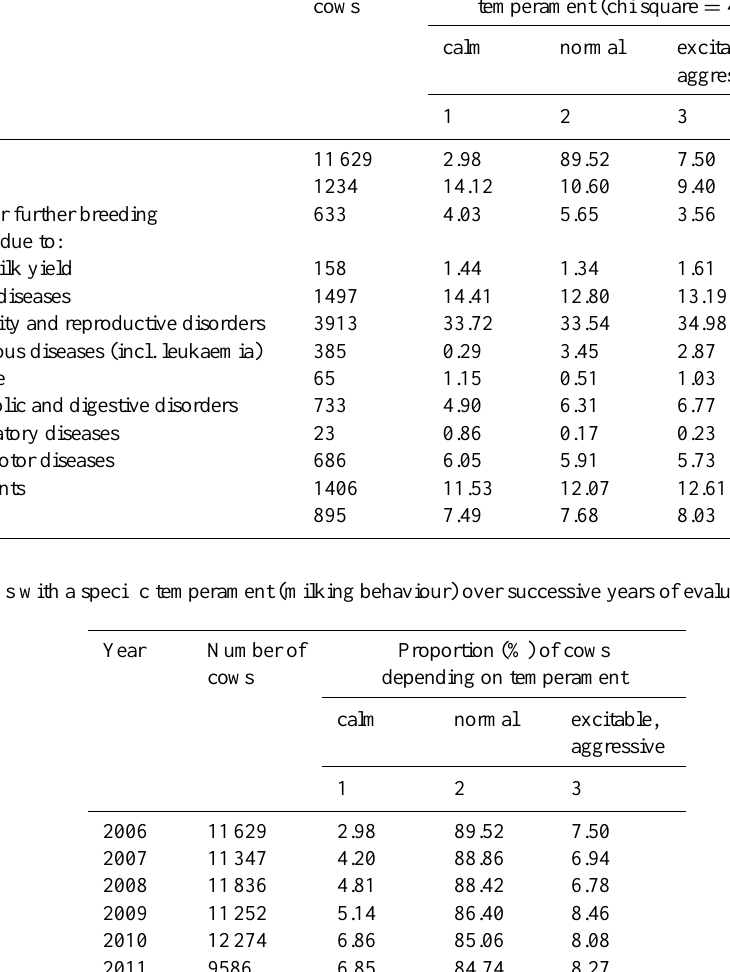
Table 2. Proportion of cows alive, sold and culled (with regard to culling reason) depending on their milking behaviour (temperament). Item Number of Proportion (%) of cows depending on their cows temperament (chi square = 43.96 xx ) calm normal excitable, aggressive 1 2 3 Total 11629 Alive Sold for further breeding Culled due to: Low milk yield